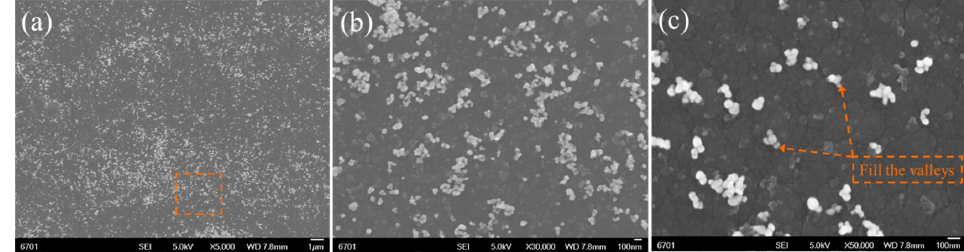
Figure 4. ( a ) FESEM images of the residual ZrO 2 -NPs on the worn a-C surfaces after friction; ( b ) magnified details of the region marked in Figure 4a; and ( c ) the distribution state of ZrO 2 -NPs.